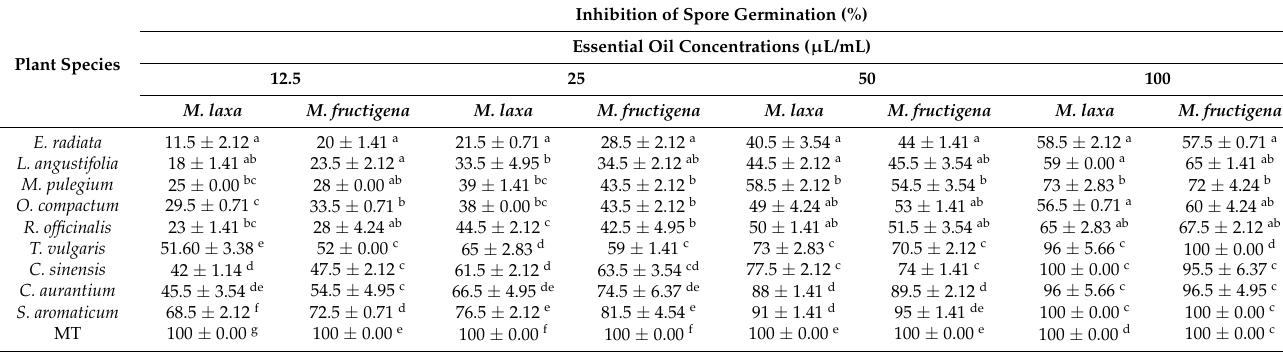
Table 3. In vitro effect of essential oil concentrations on spore germination of Monilinia laxa and Monilinia fructigena after 24 h of incubation at 25 ◦